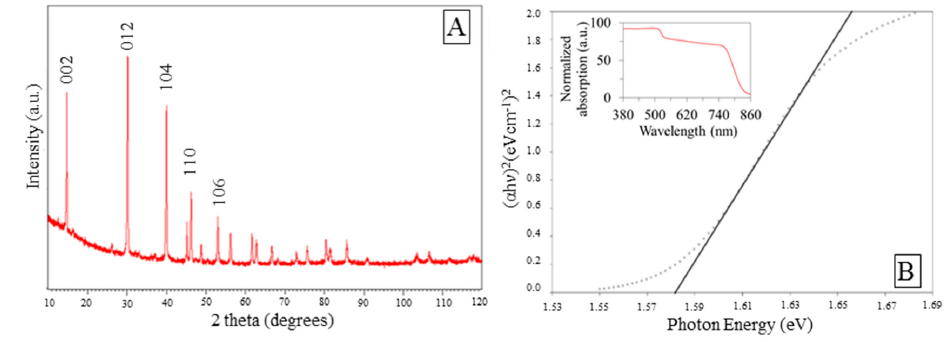
Figure 3. ( A ) X-ray diffraction (XRD) spectrum of the as-prepared MAIPb, ( B ) UV-vis spectrum and Tauc plot of the as prepared